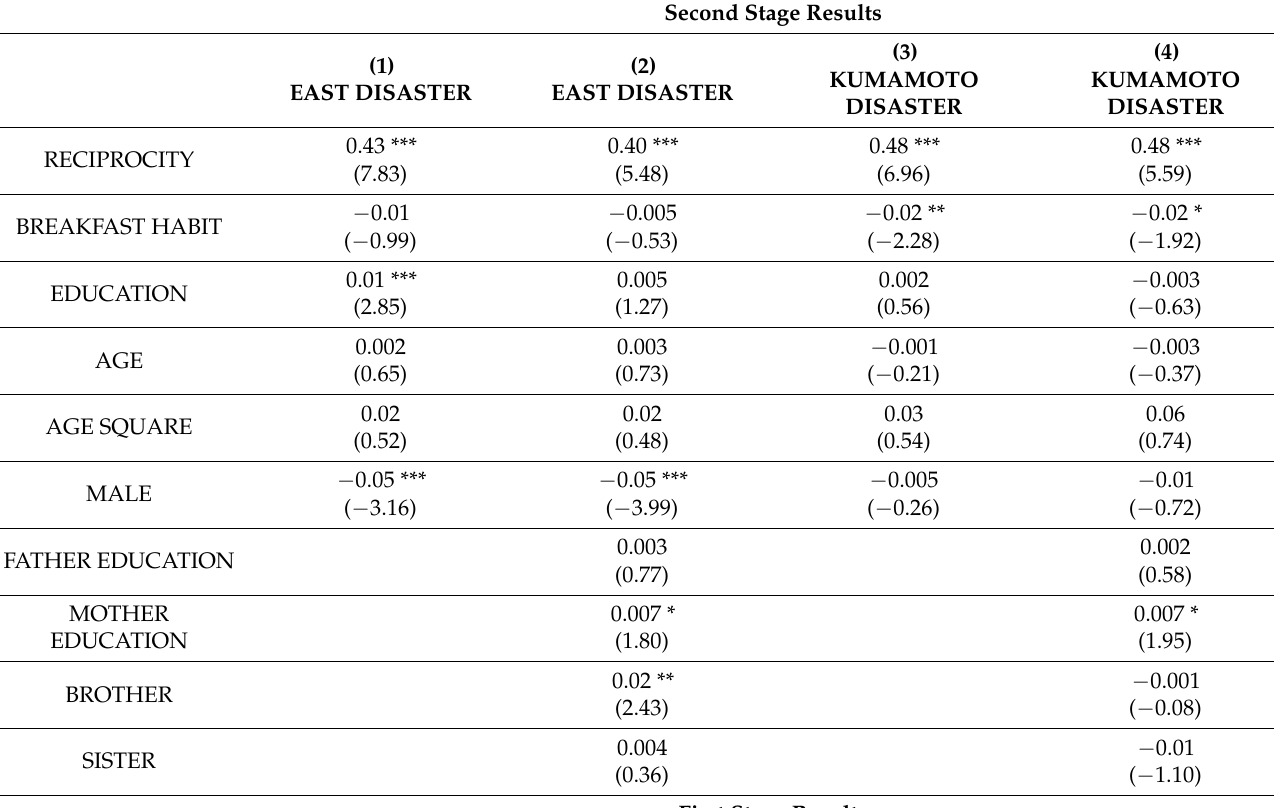
Table 3. Estimation about determinants of charitable donation (IV model): dependent variable is EAST DISASTER and KUMAMOTO